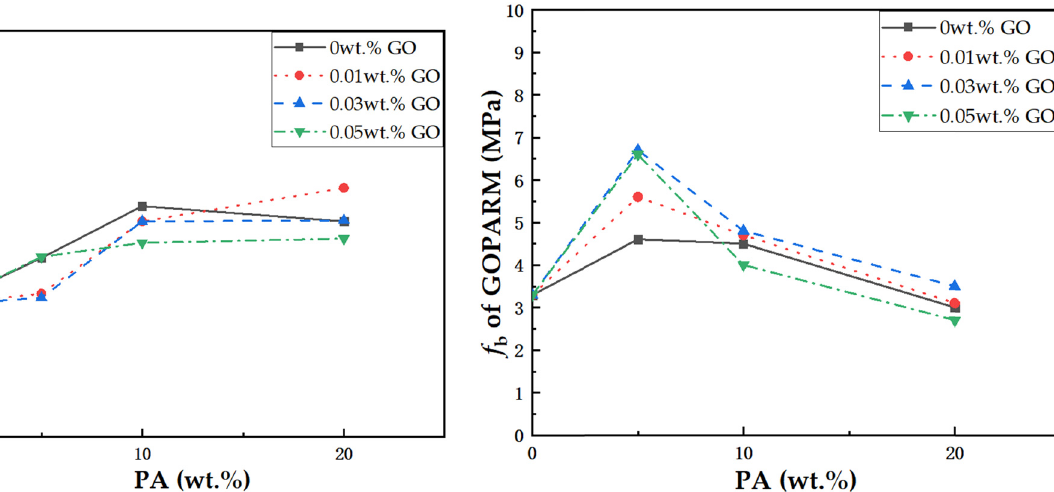
Figure 5: Variation curve of 7 days f t /f c of GOPARMs with di ff erent PA and GO dosages.